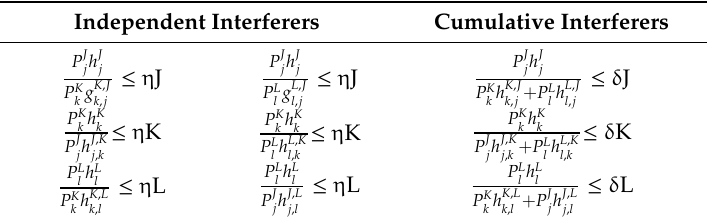
Table 4. Independent and cumulative interferer thresholds.